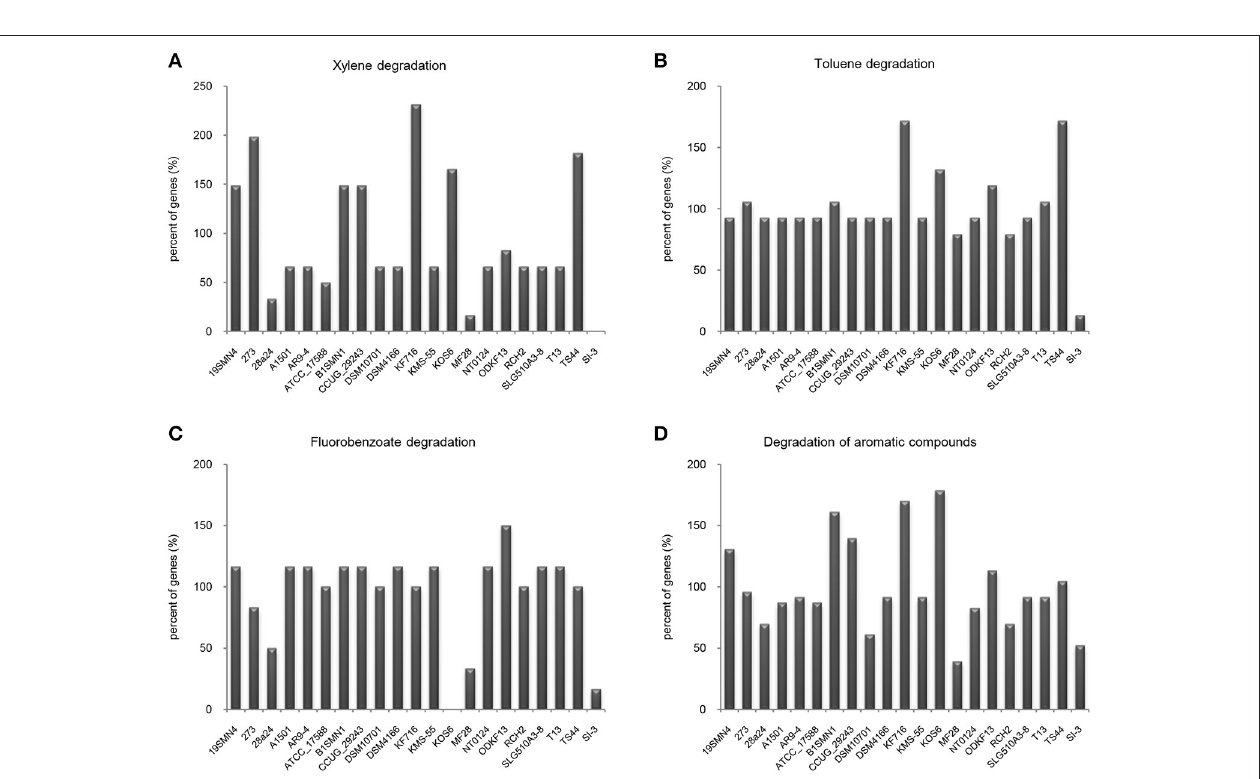
FIGURE 7 | Loss of genes involved in aromatic compounds degradation pathways in Pseudomonas sp. strain SI-3. The gene numbers in each strain were normalized to the average gene numbers of SI-3 and 20 P. stutzeri strains in xylene degradation (A) , toluene degradation (B) , fluorobenzoate degradation (C) , and degradation aromatic compounds (D)